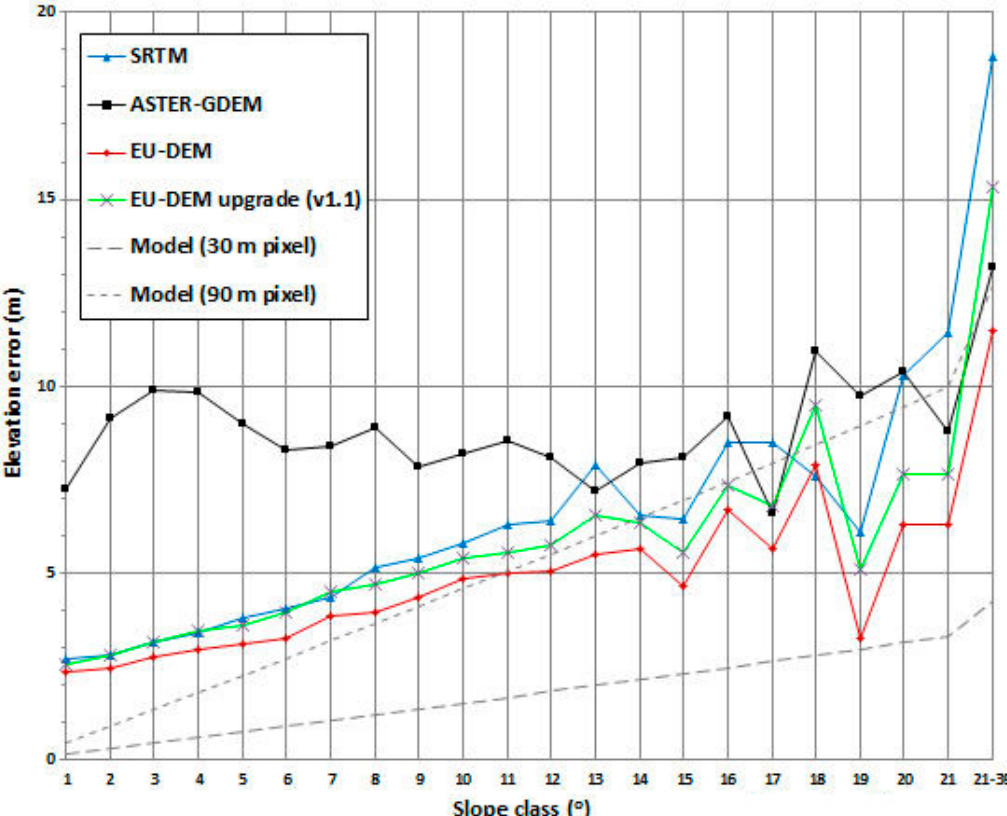
Figure 8. Absolute elevation errors plotted against slope variations for all DEMs. The modelled errors for DEMs with pixel size of 30 m and 90 m were adapted from Becek [57].